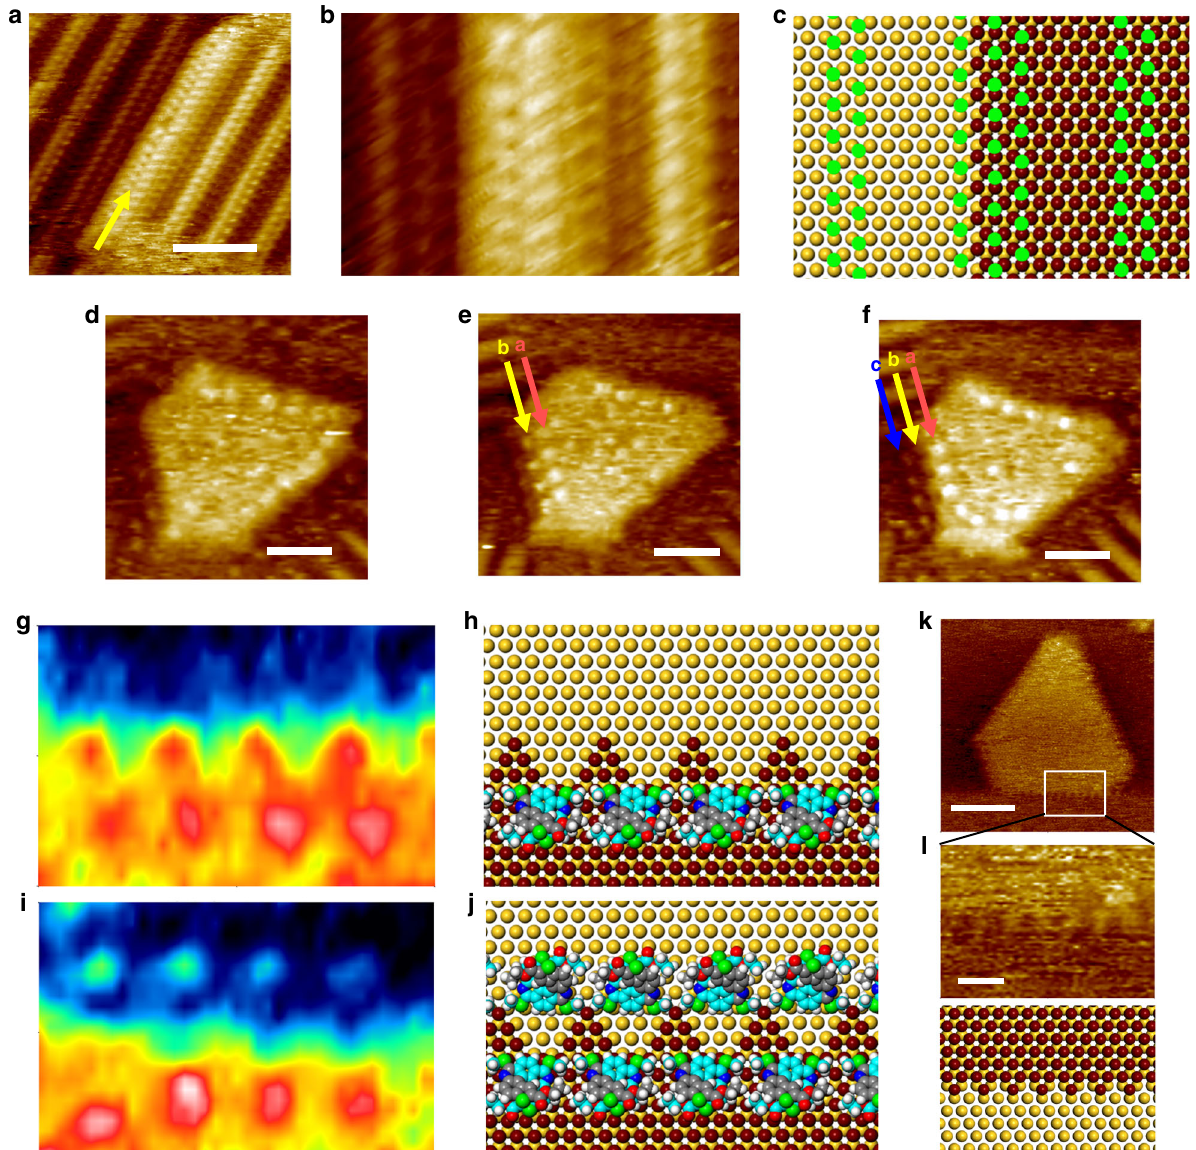
Fig. 5 The kink sites. a – c STM images ( I set = 140 pA, V bias = – 800 mV) and illustration of the step edge decorated with 2-PETs. The yellow arrow points at the step edge, while the green disks indicate Au-S bonding sites. d – f Sequential STM images showing the changes at a step ( I set = 100 pA, V = − 900 mV) between a gold island and the gold surface underneath. Arrow a and c indicate helicenes while arrow b points to the kinks. Larger scale bias images of d – f are shown in Supplementary Fig. 8. g , h STM image (4.0 × 6.0 nm 2 ) and structural model presenting sawtooth-like kinks at the edge that are decorated by a row of ( P )-1. In the structural models, Au atoms of the island are marked dark brown. i , j STM image (4.0 × 6.0 nm 2 ) and structural model showing an edge sustained by two rows of helicenes. k STM image of a triangular island after the complete removal of helicenes by the STM tip ( I set = 250 pA, V bias = – 1 V) and l close-up image and structural model of the new type of kinks. Scale bars: a , d , e , f , 4 nm; k , 5 nm; l , 1